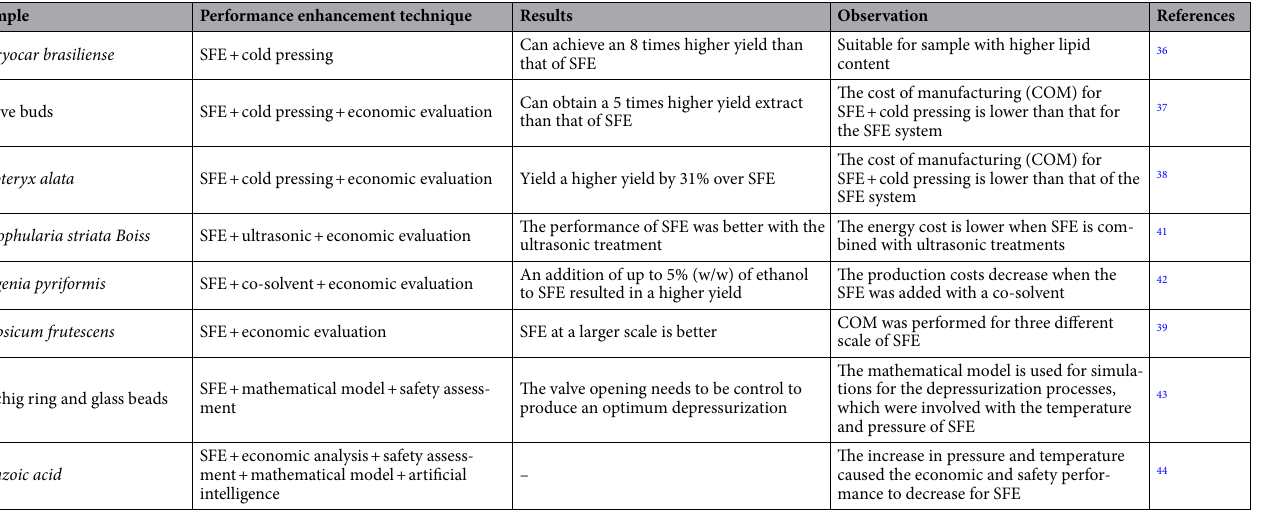
Table 2. Techniques to achieve high performance in the SFE